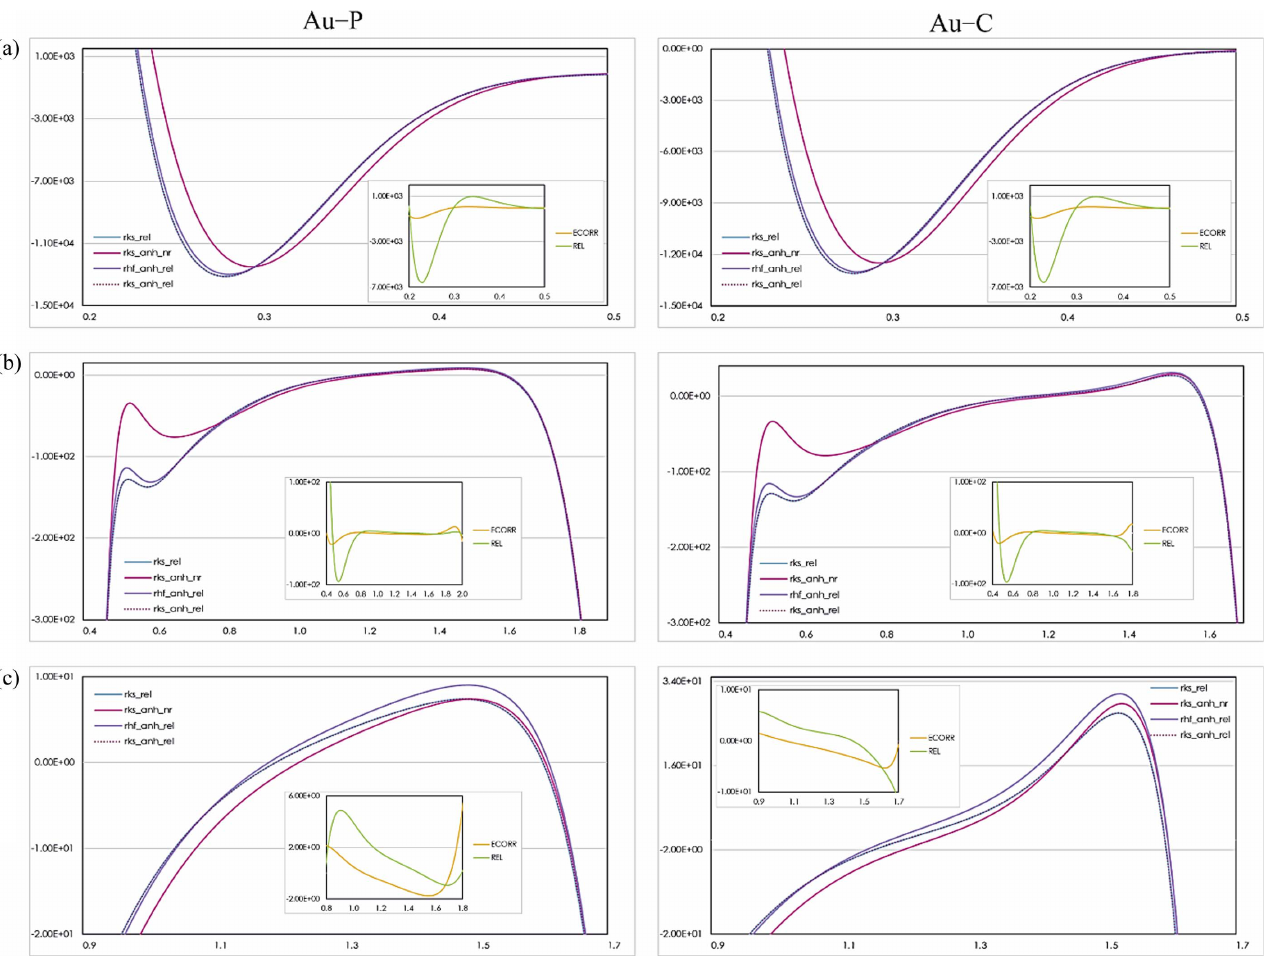
Figure 8 1D plots of negative Laplacian ( y axis, in eA˚ (cid:2) 5 ) as a function of the Au—P and Au—C bond distance ( x axis, in A˚ ) resulting from performed HARs against SP8 data. The subplots show difference electron densities resulting from the relativistic and electron correlation